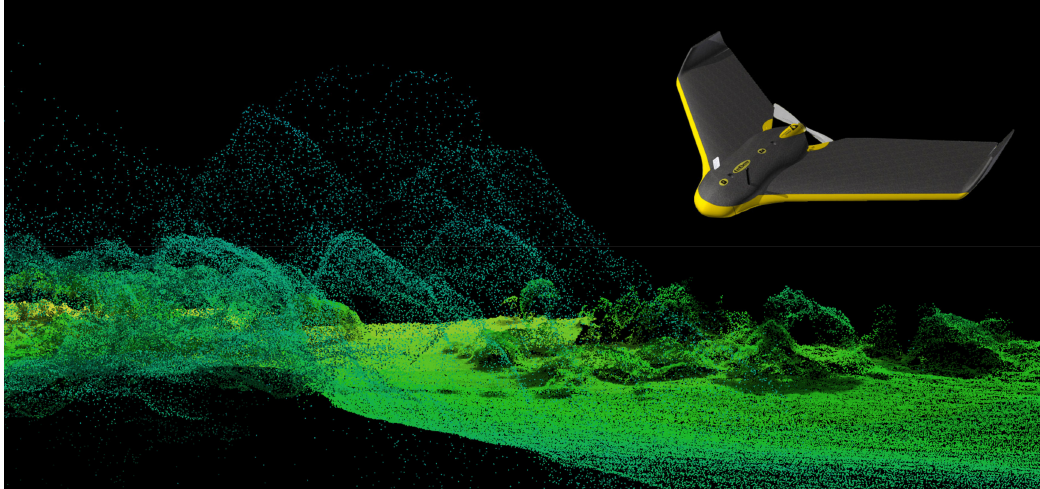
Figure 7. Preview of the loosened point clouds of Dr á tenick á sk á la with surrounding vegetation cover in FugroViewer software (this is not the full point density) and the UAV (unmanned aerial vehicle) senseFly eBee